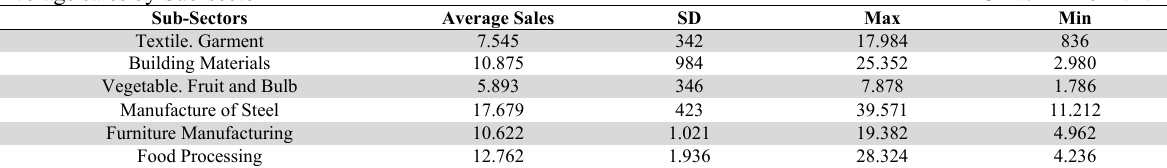
Average sales by Sub-secto Unit: Million VND Sub-Sectors Average Sales